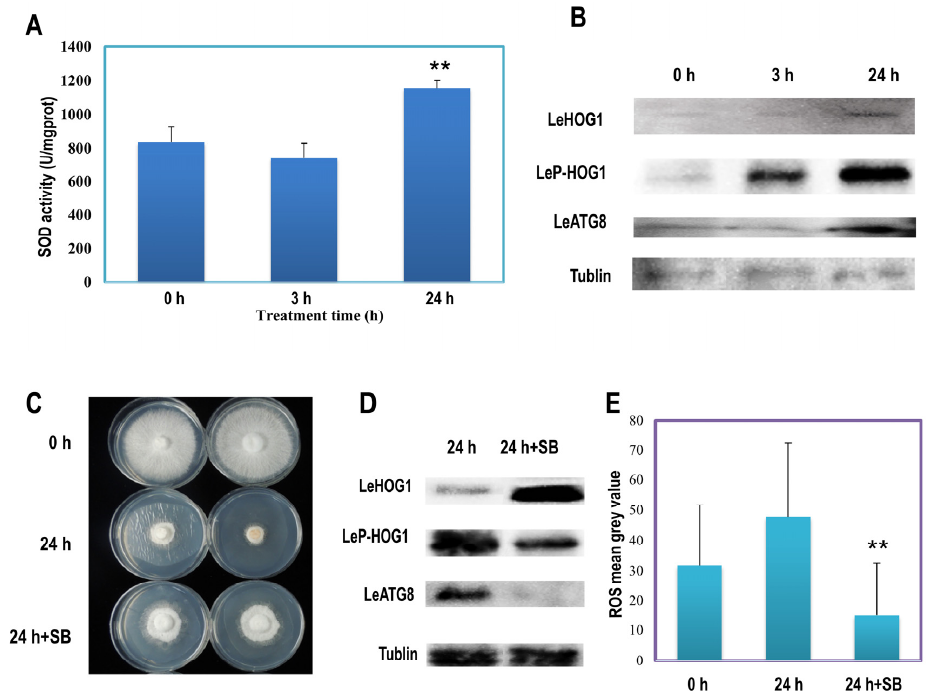
Figure 3. Related protein variation after induction and inhibition of oxidative stress in Lentinula edodes mycelia. ( A ) Superoxide dismutase (SOD) activity of mycelia treated with H 2 O 2 . Mean ± SD, n = 4. ** p < 0.01 vs. 0 h. ( B ) Western blots of LeHOG1 phosphorylation and LeATG8 expression under oxidative stress. ( C ) Mycelial morphology after 24 h treatment with H 2 O 2 or SB203580 inhib- itor and H 2 O 2 . ( D ) Western blots of LeHOG1 phosphorylation and LeATG8 expression after 24 h